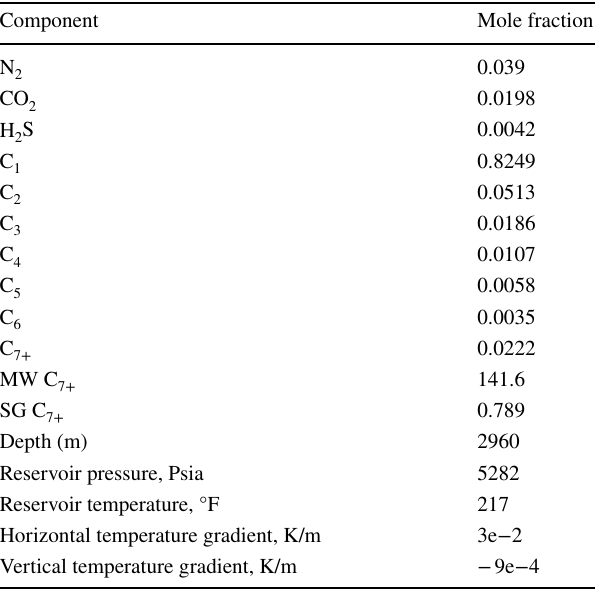
Table 2 Gas condensate sample, reference point values, selected from